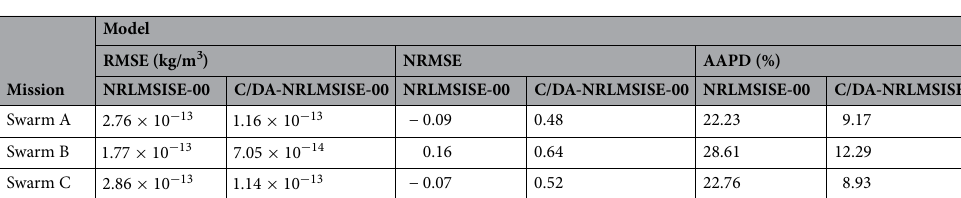
Table 1. A summary of the statistical measures derived during the analysis mode between the original NRLMSISE-00 and C/DA-NRLMSISE-00 models. Here GRACE-TNDs are used as observations within the C/ DA procedure, and the results are evaluated with those of the Swarm mission during February